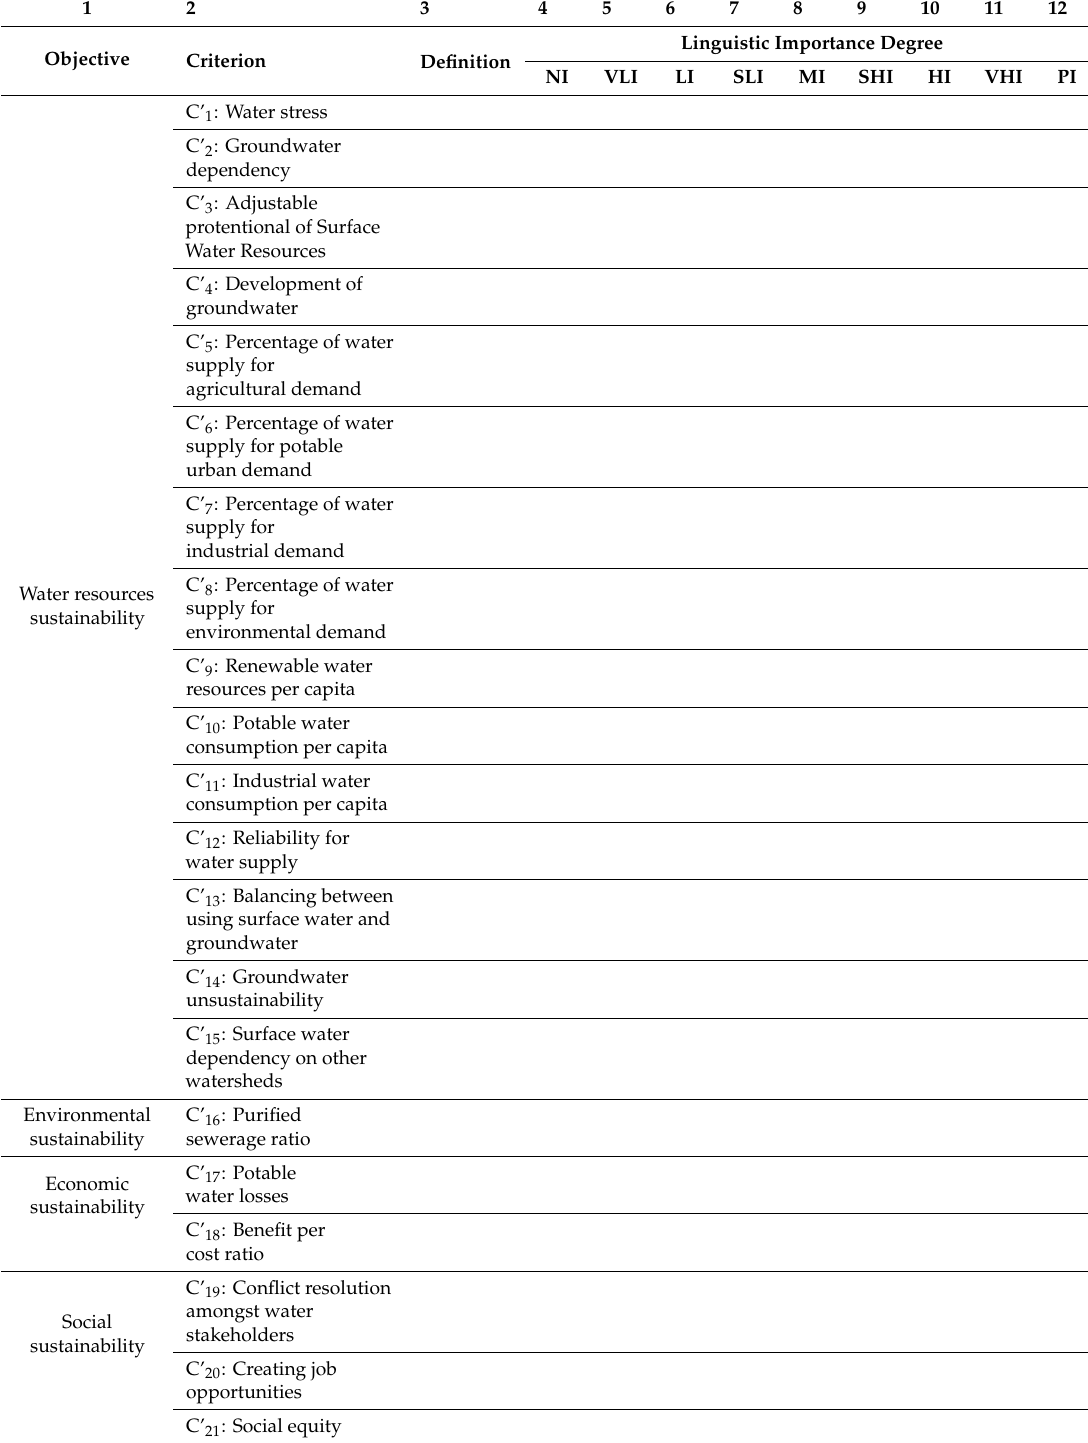
Table A3. Sample questionnaire for the linguistic importance degrees of the initial